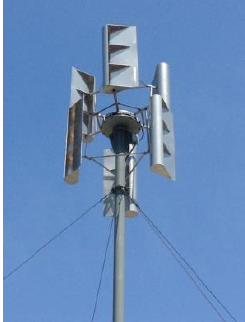
Figure 33. Wind turbine prototype. Table 6. Basic parameter of Wind tunnel model.